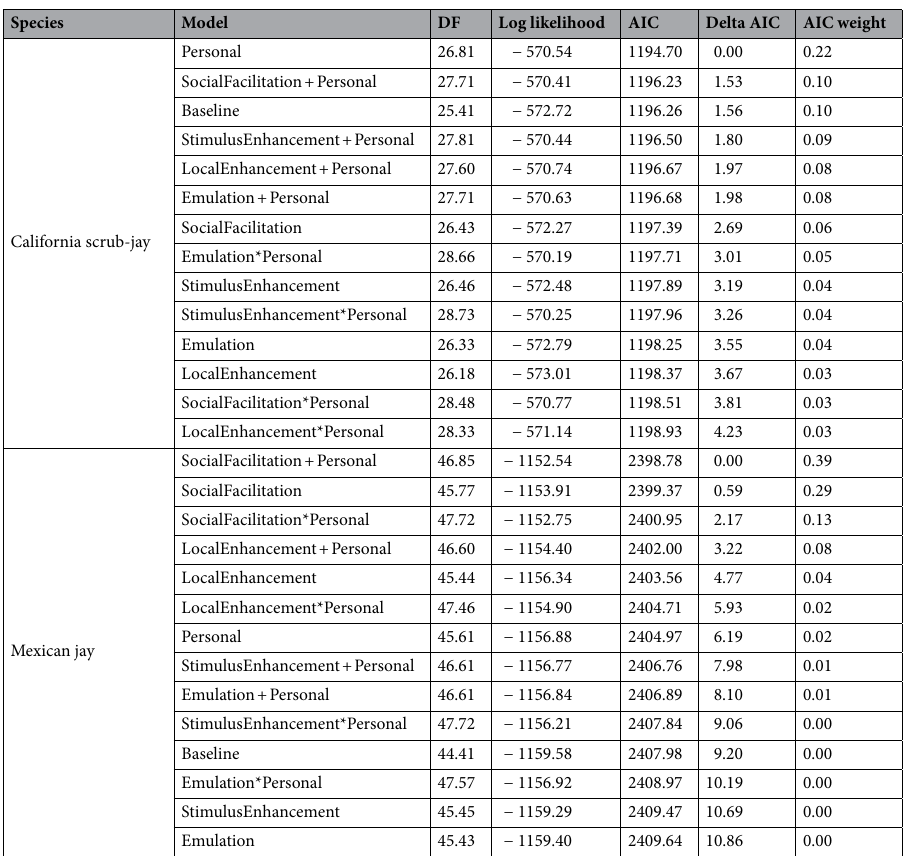
Table 2. AIC comparison of models evaluating the effects of personal information and four social learning mechanisms (social facilitation, stimulus enhancement, local enhancement, and emulation) on the rate at which two jay species interact with novel doors on a multi-door foraging task. All models built on the baseline model which included random effects for group, individual, door type, and apparatus location, as well as fixed effects for individual age, habituation to the puzzle box, and previous success